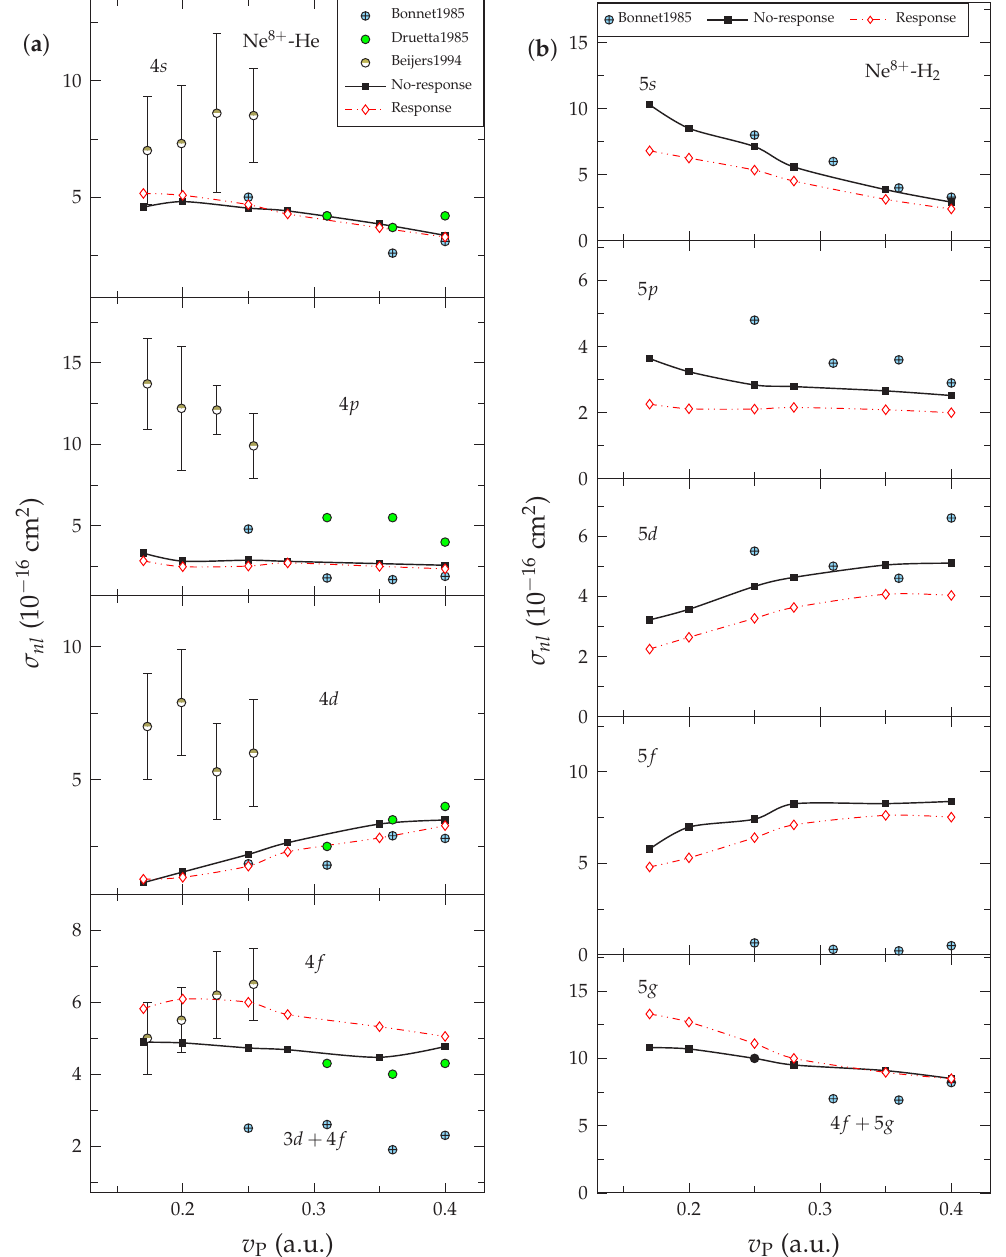
Figure 2. ( a ) Partial capture cross sections of 4 l -states with respect to the impact speed for Ne 8 + –He collisions. Capture events correspond to pure SEC only. Experiment: Bonnet et al. [13] (40% uncertainty); Druetta et al. [14] (30% uncertainty); Beijers et al. [15]. Theory: present work (no-response approximation and target-response model). ( b ) Same as ( a ) but 5 l -states for Ne 8 + –H 2